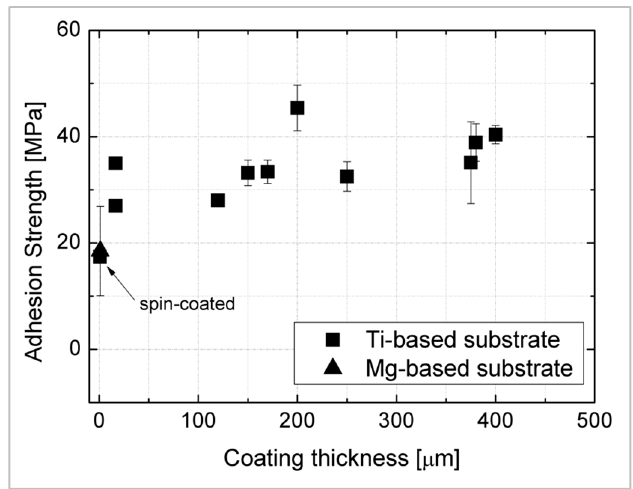
Figure 3. Adhesion strength and thickness of bioactive coatings. Data obtained by merging data available in Tables 4 and 5.